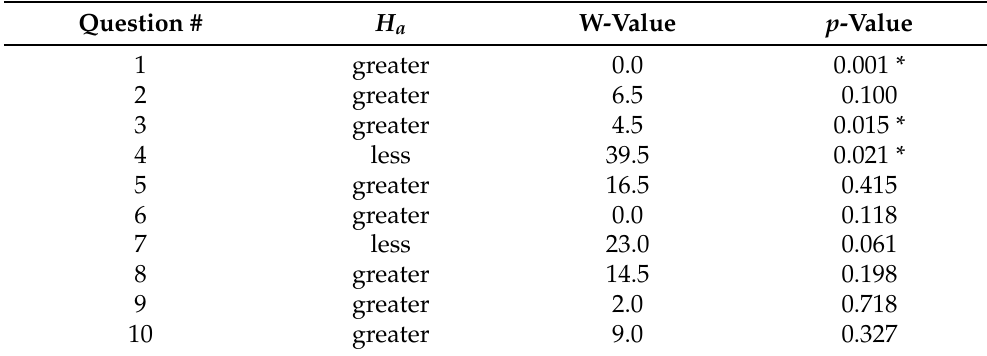
Table 3. Results of the Wilcoxon signed-rank test on question pairs from question set 1. Question numbers are the same as in Section 4.4.2. H a refers to the alternative hypothesis: whether the answers from the second sample would be greater than or less than those from the first sample. Reported are the W- and p-values obtained from the tests. * indicates p ≤ α .